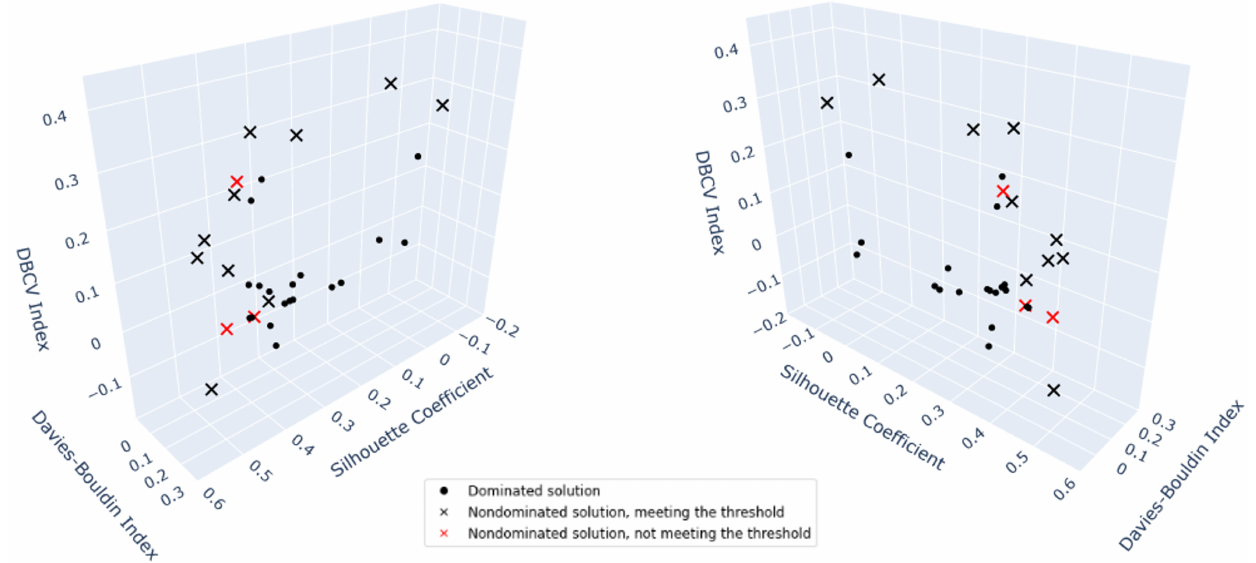
Figure 3. A three-dimensional representation of the optimization